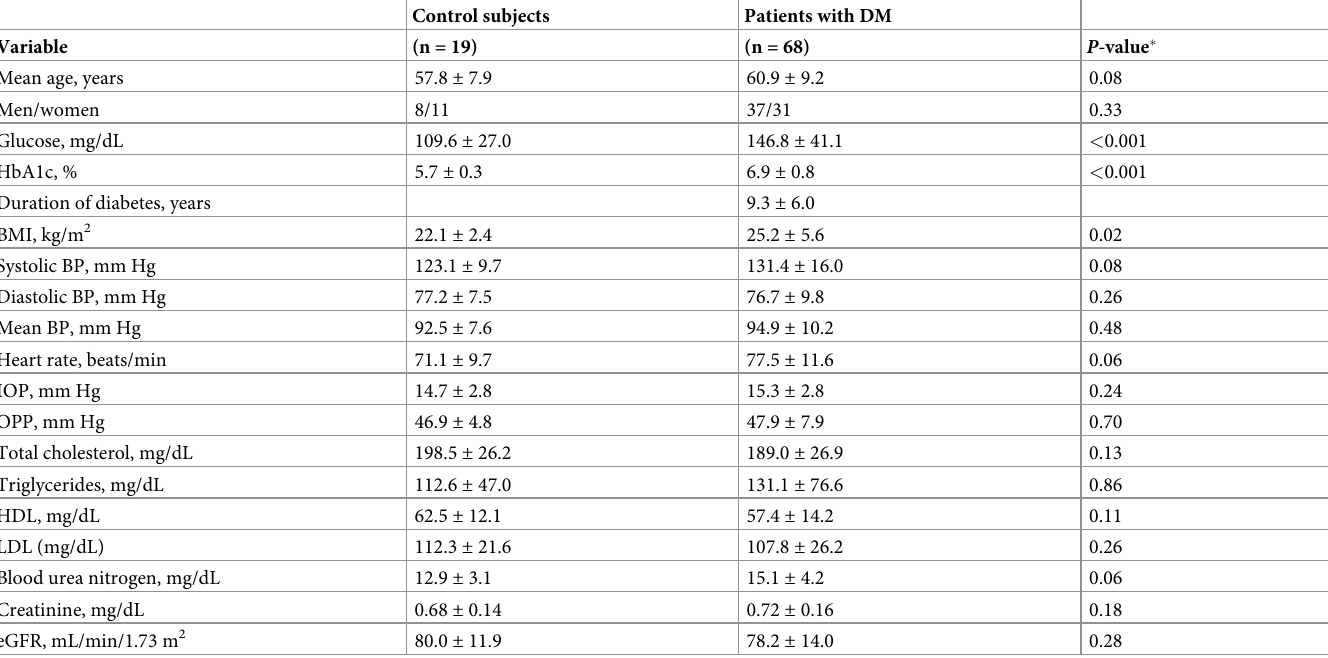
Table 1. Characteristics of control subjects and patients with DM.